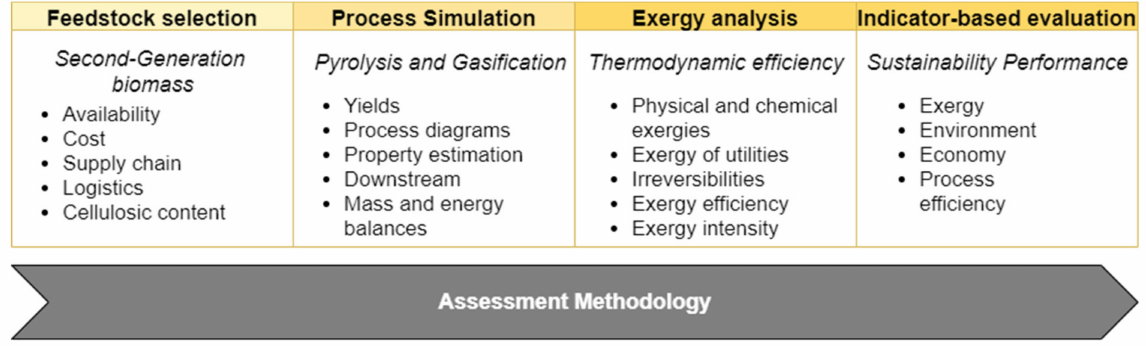
Figure 1. Assessment methodology used in this